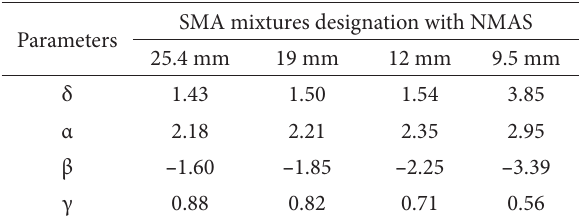
Table 3. Parameters for dynamic modulus master curve